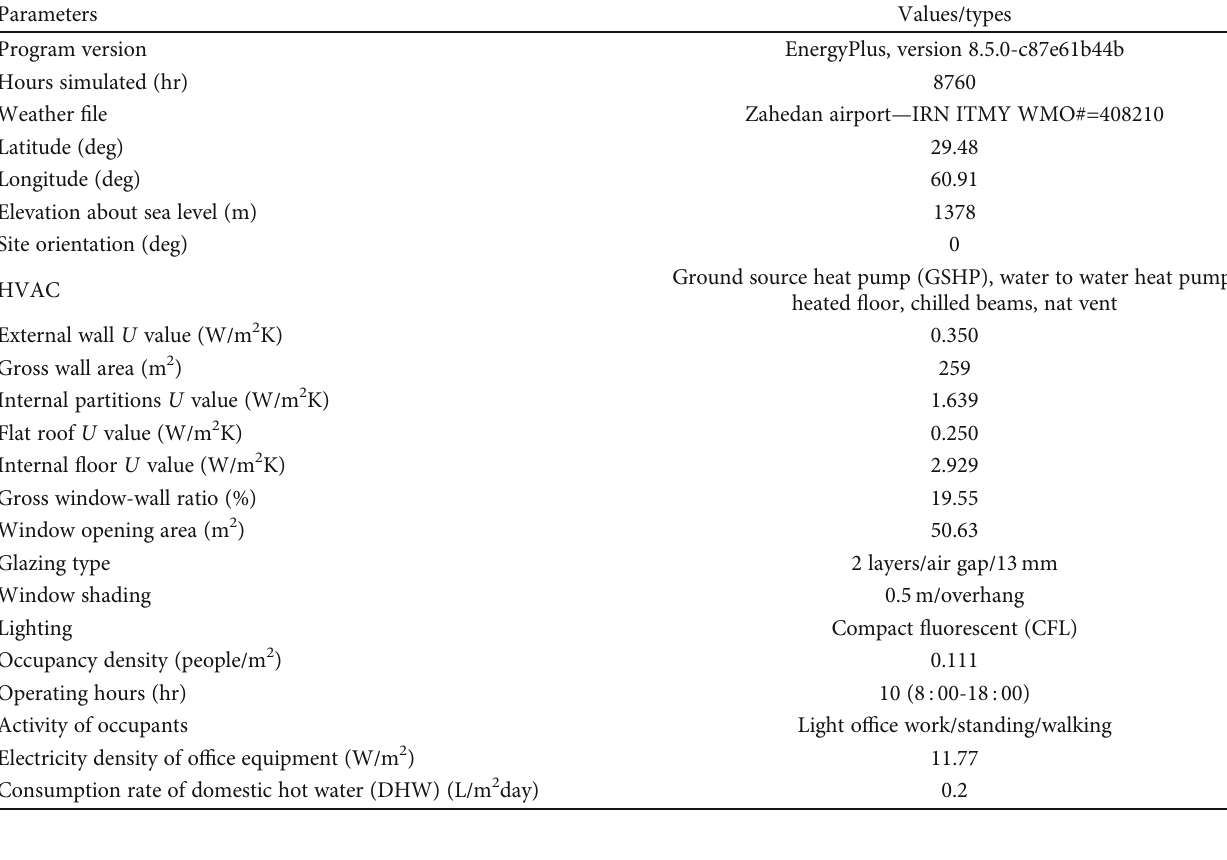
Table 1: Modeled building ’ s speci fi cation and site location.